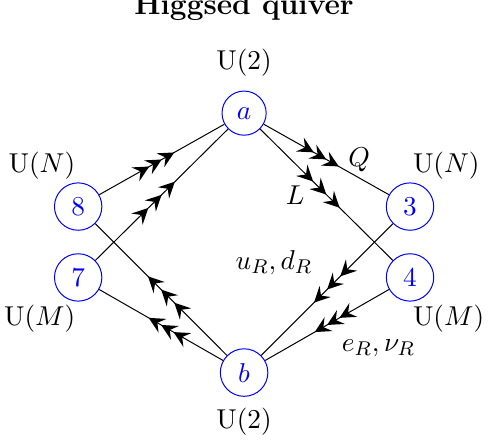
Figure 7 . Higgsed quiver diagram dP 5 showing only the chiral matter